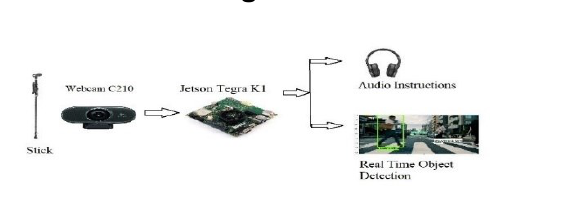
Figure 1. Flowchart depicting the hardware used in the